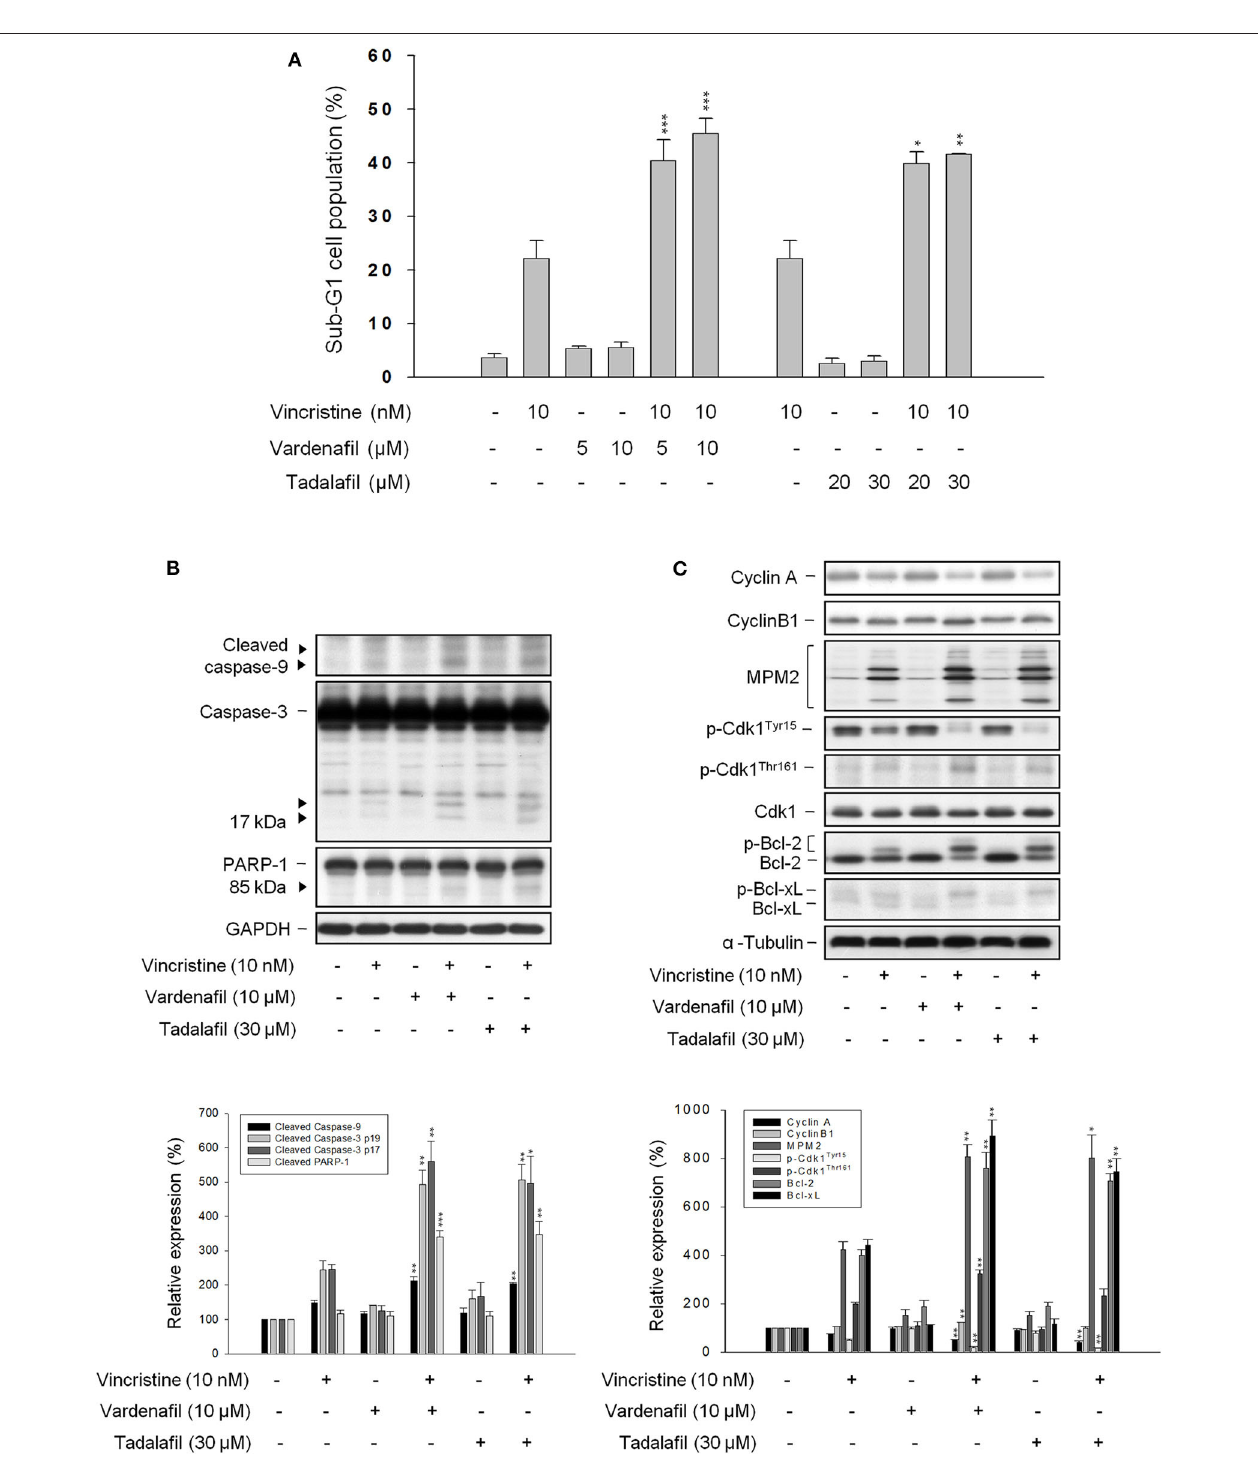
FIGURE 3 | Effect of vardenafil and tadalafil on vincristine-induced sub-G1 population and protein expression. PC-3 cells were incubated in the absence or presence of the indicated agent for 48h (A) or 24h (B,C) . The cells were harvested for propidium iodide staining to analyze the distribution of cell populations at sub-G1 (apoptosis) phase using FACScan flow cytometric analysis (A) , or the cells were harvested and lysed for the detection of protein expression by Western blot analysis (B,C) . Data are expressed as mean ± SEM of three independent determinations. * P < 0.05, ** P < 0.01, and *** P < 0.001 compared with vincristine alone.